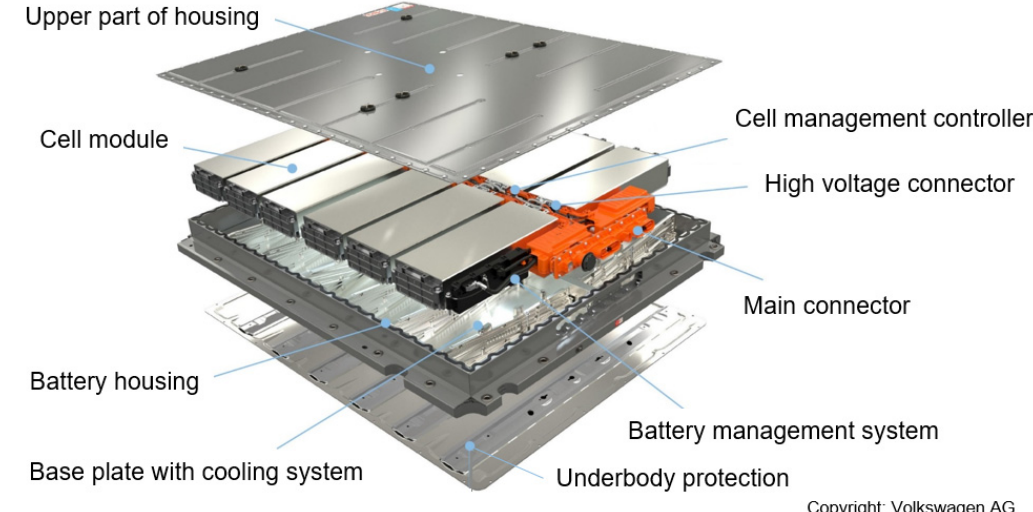
Figure 12. Configuration of a modern battery system for BEV, modified from [38].